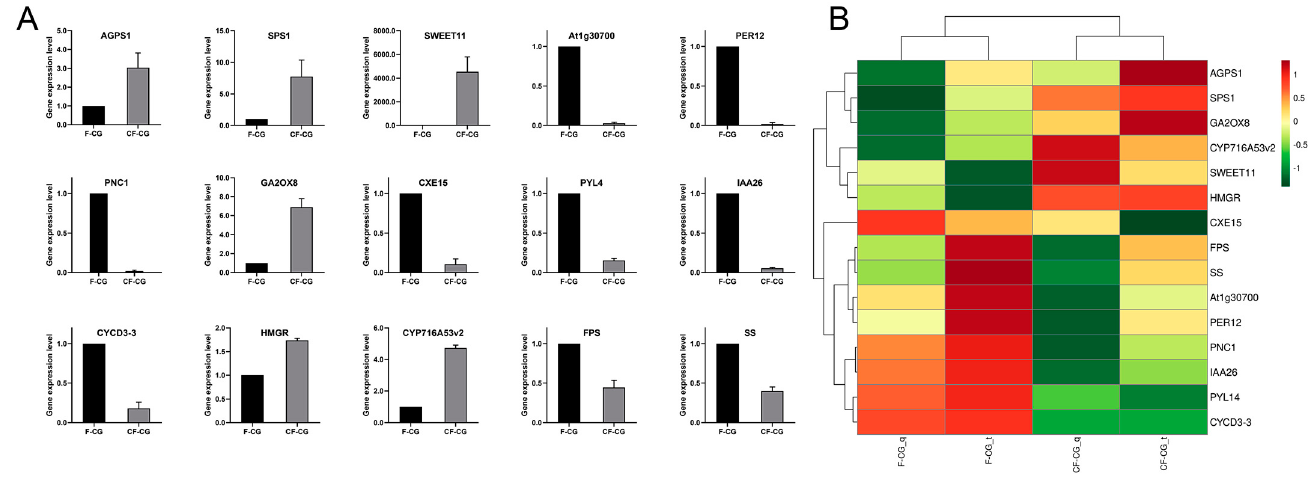
Figure 6. ( A ): qRT-PCR verification of differentially expressed genes in CF-CG and F-CG. ( B ): qRT- PCR and RNA sequence correlation analysis.